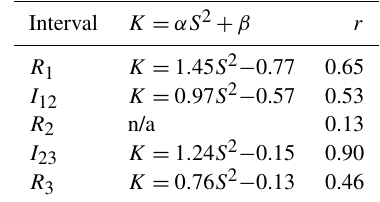
Figure 5. Probability distribution functions (PDFs) of (cid:49)B(τ) for τ = 10s (continuous line) and τ = 100s (dashed line). (a) The in- terior region of IMFR-1, (b) the interface of IMFR-1 and IMFR-2, (c) the interior of IMFR-2, (d) the interface of IMFR-2 and IMFR- 3, and (e) the interior of IMFR-3. A Gaussian distribution function is represented by the gray area. Table 4. The least-square fits of Eq. (7) computed from the scatter plots of Fig. 7 ( τ = 100s). The fitting function of IMFR-2 was not applicable (n/a) due to the small correlation